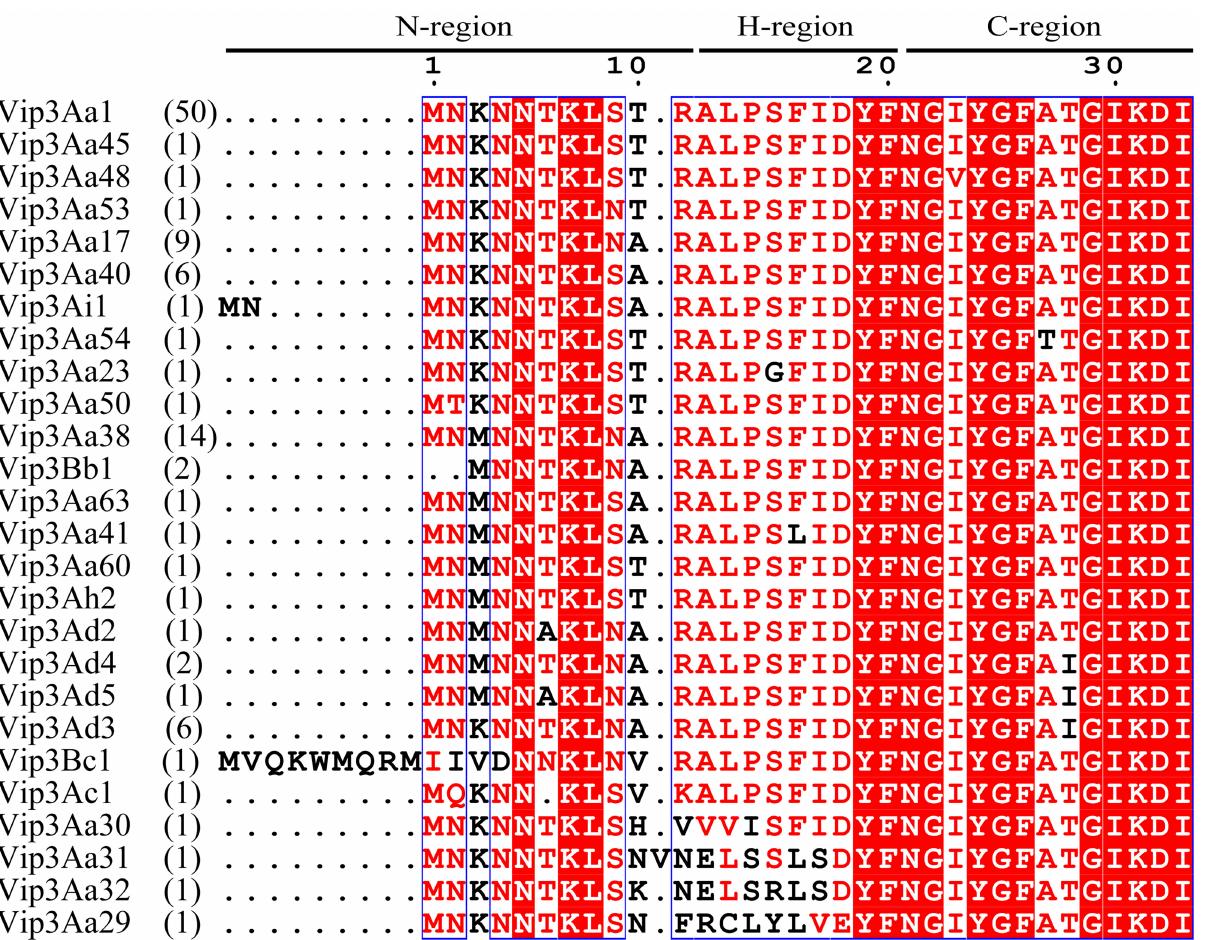
FIGURE 1 | The alignment of the representative Vsp sequences. The predicted N-, H-, and C-regions of SP are indicated. The numbers of genes sharing the corresponding sequences are indicated in parentheses.